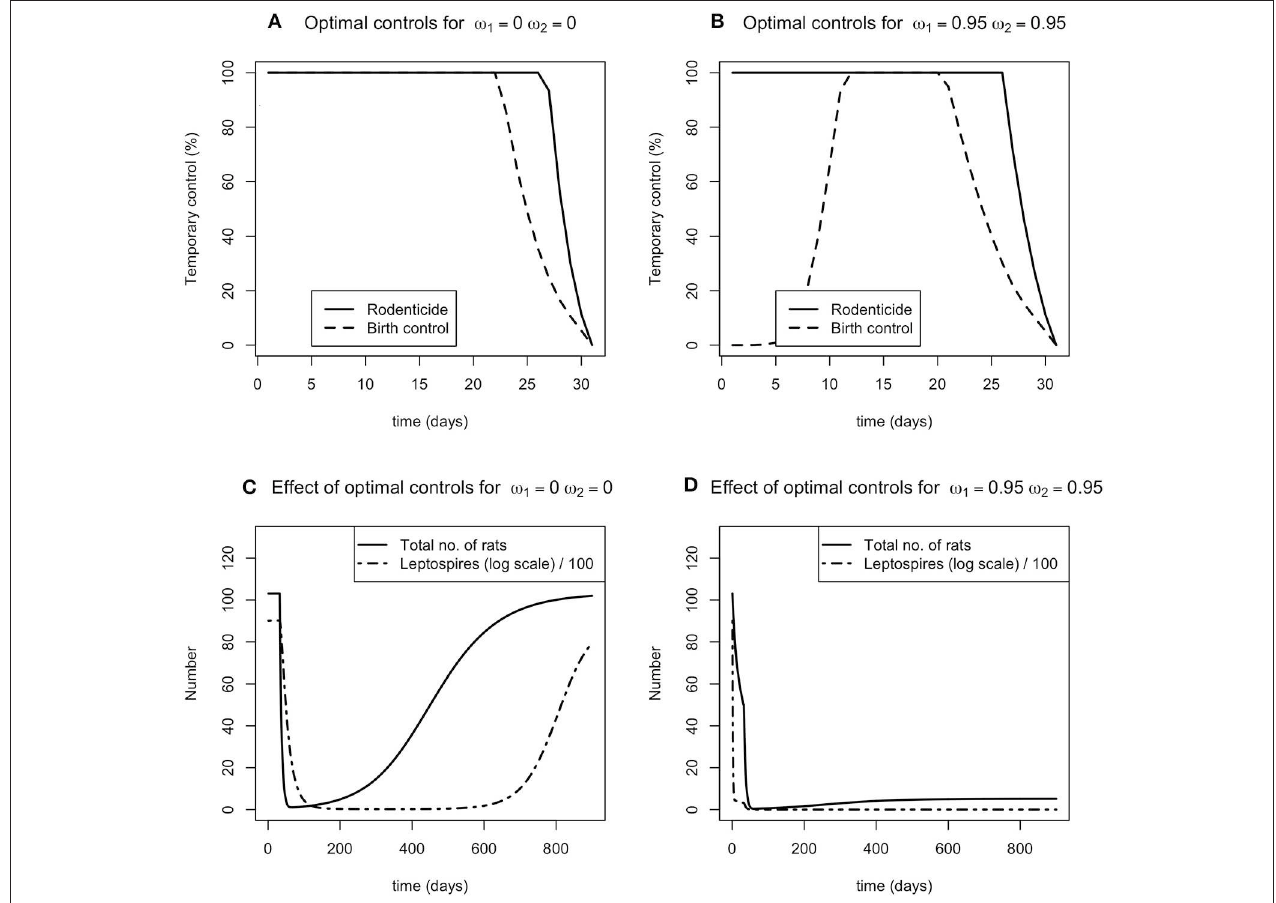
FIGURE 2 | (A,B) The optimal level of the time dependent controls, rodenticide (solid line) and resource reduction (dashed line), when the environmental controls are a) not applied ( ω 1 = 0, ω 2 = 0), (B) applied at a high level ( ω 1 = 0.95, ω 2 = 0.95). (C,D) The effect of no and high control ( C,D , respectively) on the total number of rats (solid line) and number of leptospires (dot dashed